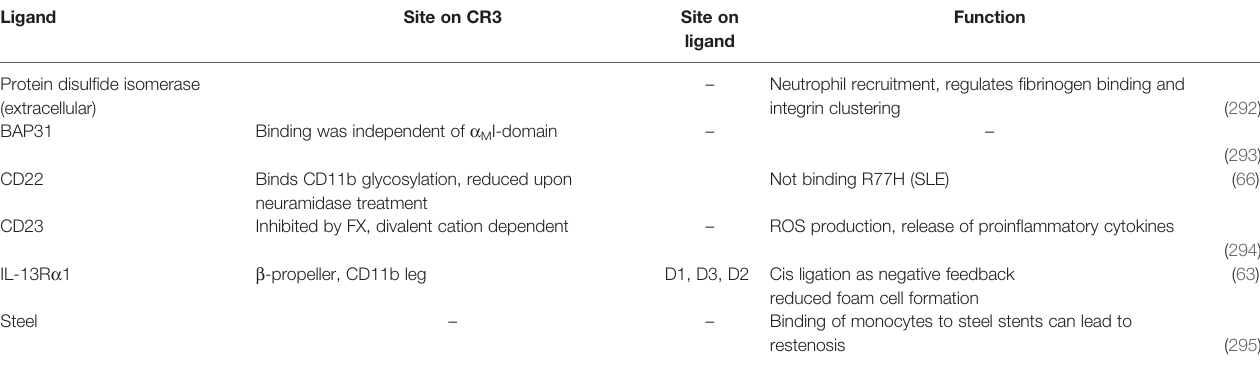
TABLE 8 | Involvement of CR3 in additional